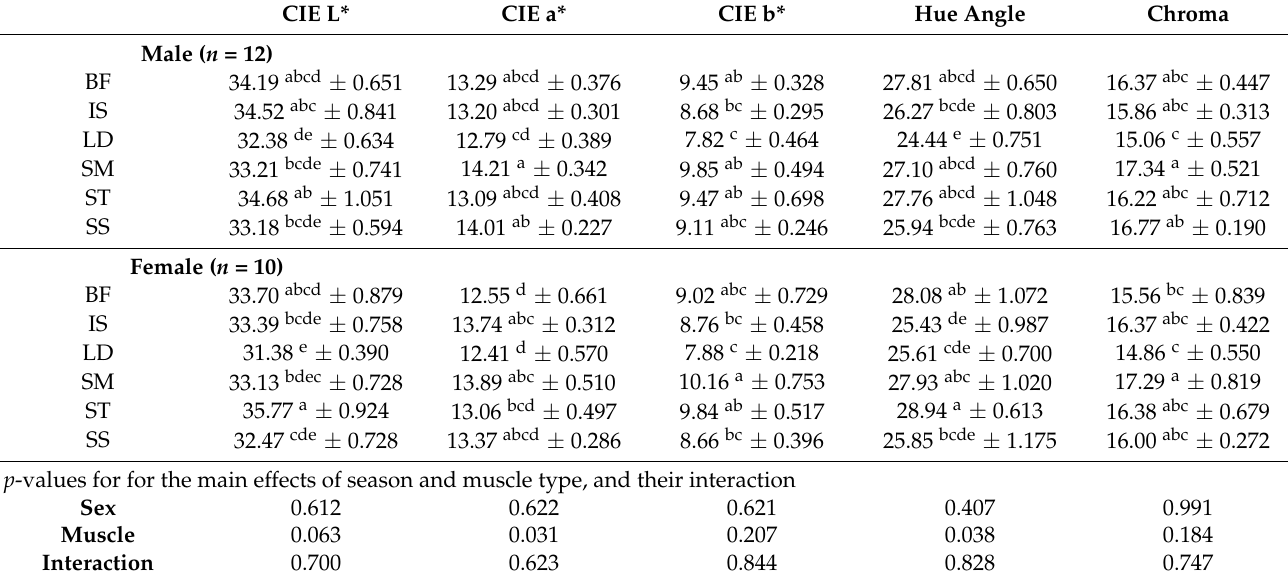
Table 4. Mean values ( ± standard errors) and least significant differences for CIE L*, a* and b* values, hue angle and chroma for the longissimus dorsi (LD), biceps femoris (BF), semimembranosus (SM), semitendinosus (ST), supraspinatus (SS) and infraspinatus (IS) muscle from male and female red hartebeest from Namibia. CIE L* CIE a* CIE